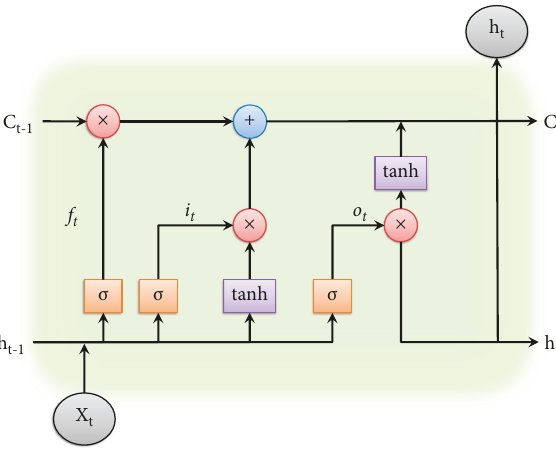
Figure 5: LSTM network structure. Figure 6: BiLSTM network